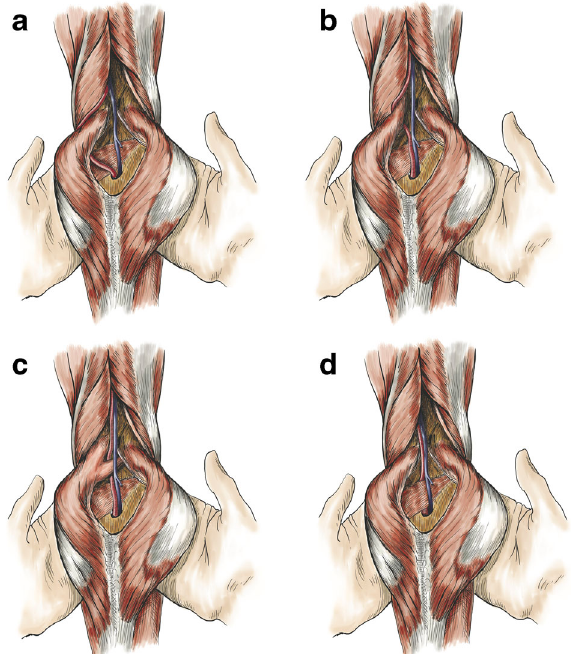
Fig. 5 Drawings illustrate the classification scheme for PAES. ( a ) Type 1: the medial head of the gastrocnemius muscle has normal insertion, displacing the popliteal artery around and beneath the muscle. ( b ) Type II: themedialheadofthegastrocnemiusarises from anabnormal position, displacing the popliteal artery medially. ( c ) Type III: entrapment is caused by an abnormal slip of the gastrocnemius muscle. ( d ) Type IV: entrapment is caused by a fibrous band or by the popliteal